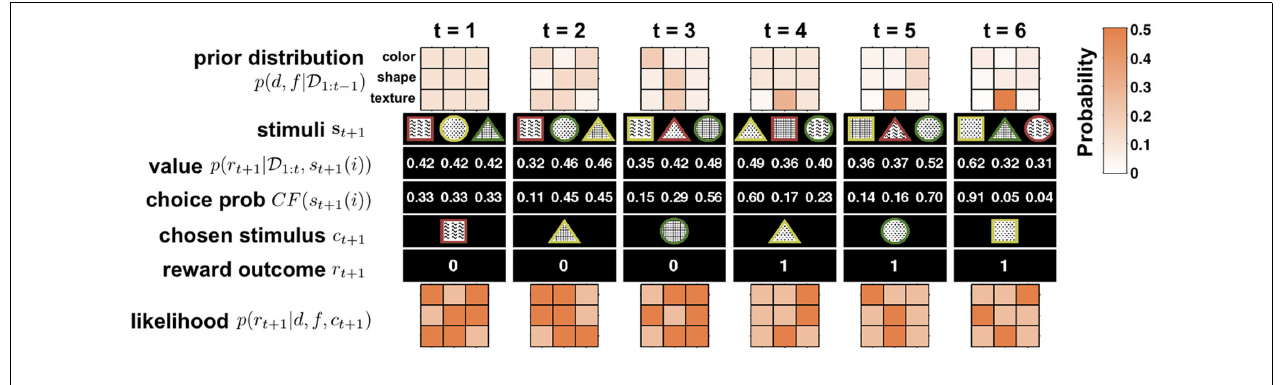
FIGURE 2 | Illustration of six time steps of the Bayesian model in action with no change-points. Starting from t = 1 from top to bottom: the model begins with a uniform prior distribution over dimension d and feature f , p ( d , f | D 1: t ) (rows in 3 × 3 plot denote dimensions, with three features each; shading denotes probability; see scale on right). Next the three stimuli, s t + 1 = { s t + 1 (1), s t + 1 (2), s t + 1 (3)}, are observed and their values, p ( r t + 1 | D 1: t , s t + 1 ( i )), computed. Given these values the choice probability CF ( s t + 1 ( i )) is computed for each option (here with β = 10) and a choice c t + 1 is made. After the choice the model receives feedback about the reward,